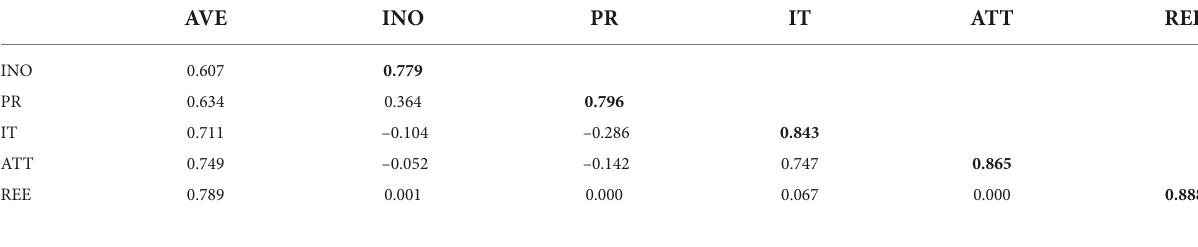
TABLE 5 Correlations and discriminant